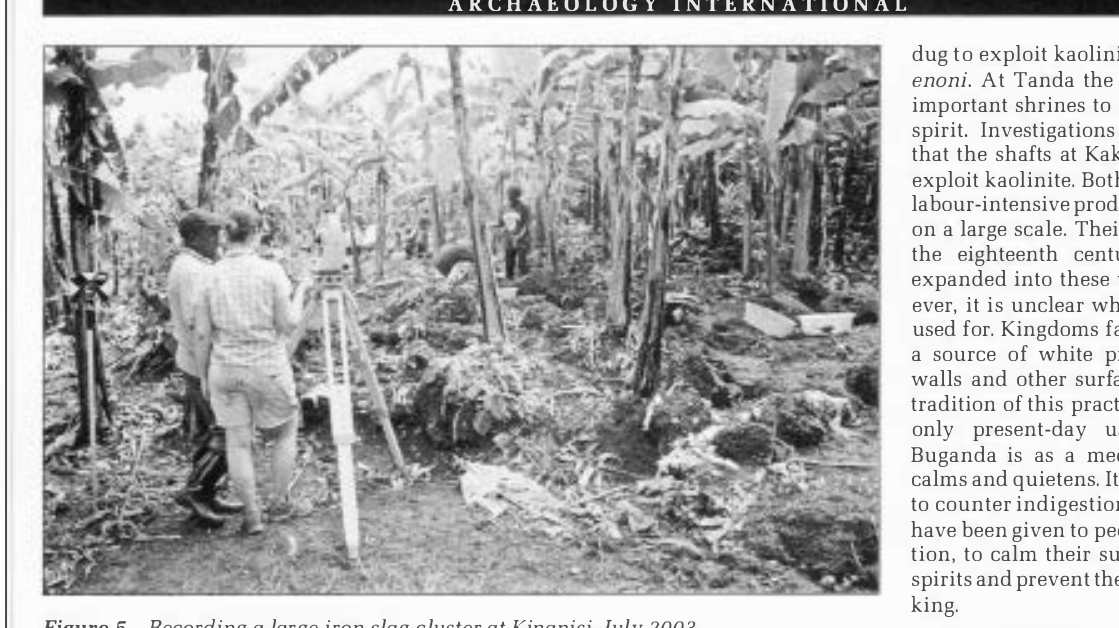
Figure 5 Recording a large iron-slag cluster at Kinanisi, July 2003. In contrast to the grinding hollows in the forest, the gaming boards at Sanzi are spread across the grass-covered hillside. They were almost certainly used to play omweso, a tactical counting game that is also played on wooden boards, and may well have been made by herdsmen. The grass-covered hills were (and still are) an important source of pasture that allowed livestock to stay clear of the unhealthy tsetse-infested forest during the day. In our excavations at Sanzi the only animal remains recovered were a few cattle teeth. They were dated by the radiocarbon method to the late first millennium AD and provide the earliest evidence for cattle on the northwestern shores of the lake. The hilltops are also sources of iron ore, which often occurs in rock outcrops just below the plateau